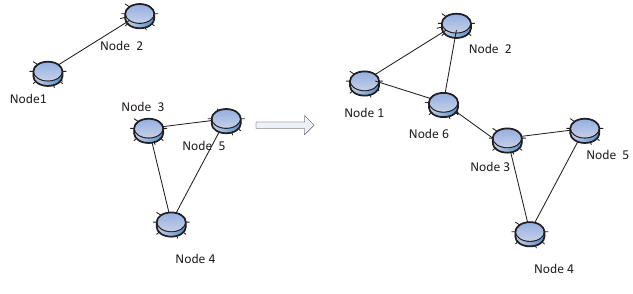
Figure 6. Topology control: the new Node 6 is added to recover the